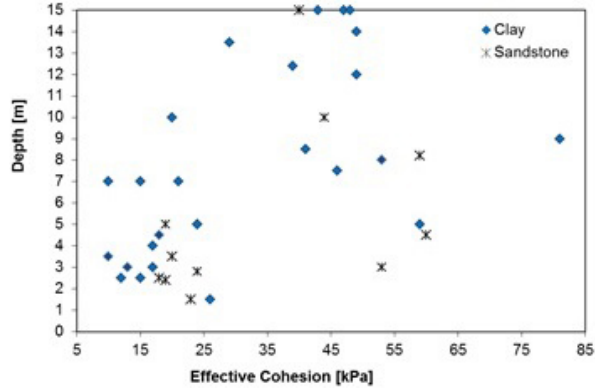
Fig. 2. Effective cohesion measured in the municipal territory of Castelfranci.